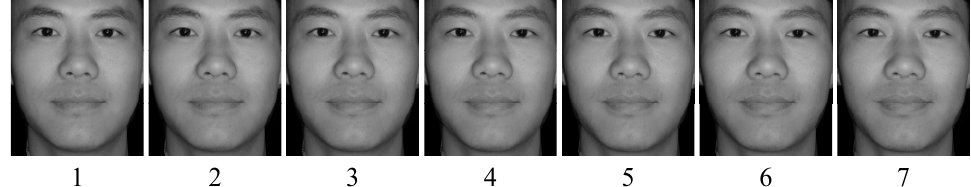
Figure 1. Levels of applied morphing. The illustrations are examples of morphed faces. We selected seven morphs, ranging from somewhat high attractiveness to somewhat low attractiveness. These images were morphed to be attractive from 62.5% to 37.5%; level 4 was the most ambiguous (50%